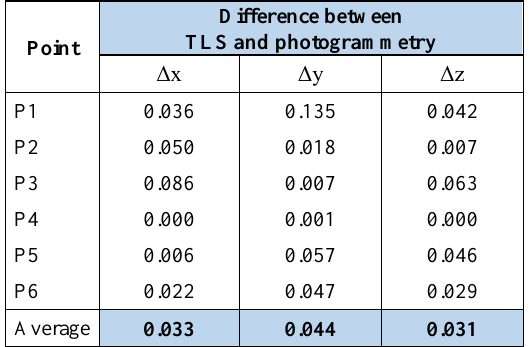
Table 1. Distance difference (absolute values) between TLS and photogrammetric models, in meters.